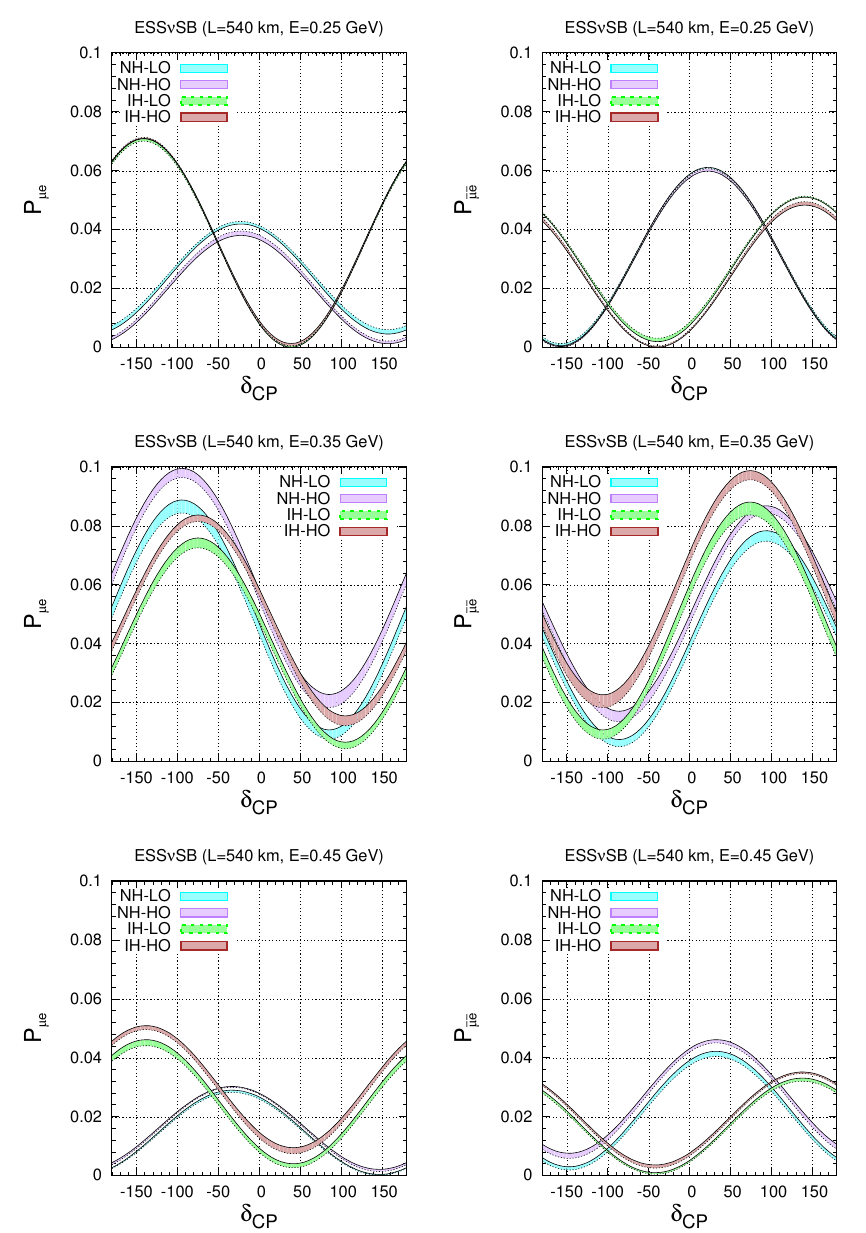
Figure 2 . Appearance probability for ESS (cid:23) SB for di(cid:11)erent energies. The bands are obtained by varying (cid:18) 23 in lower octant and upper octant. See text for